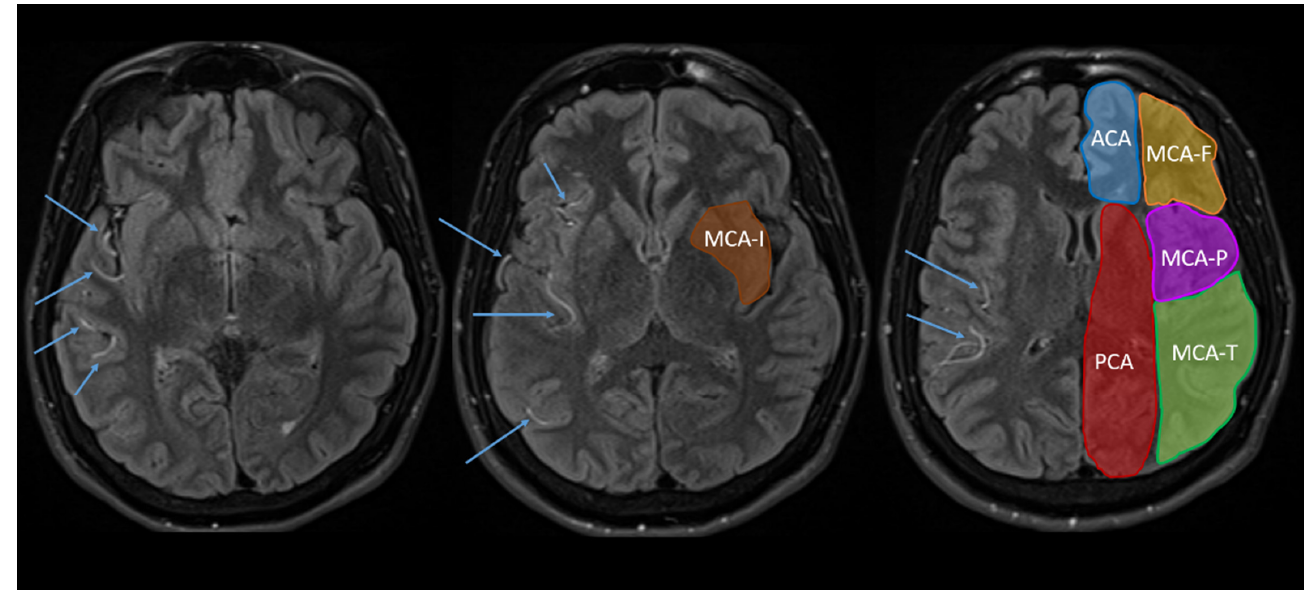
Figure 1. Examples of FHVs (indicated by the arrows) and vascular regions used for the NIH-FHV score: the anterior cerebral artery (ACA, blue), posterior cerebral artery (PCA, red), and four regions of the middle cerebral artery (MCA)—the MCA-frontal (MCA-F, orange), MCA-temporal (MCA-T, green), MCA-parietal (MCA-P, purple), and MCA-insular (MCA-I, brown). Note that no FLAIR im- aging for the current study was shared by the NIH. Thus, this example of FHVs is from a participant in Bunker et al. [13].